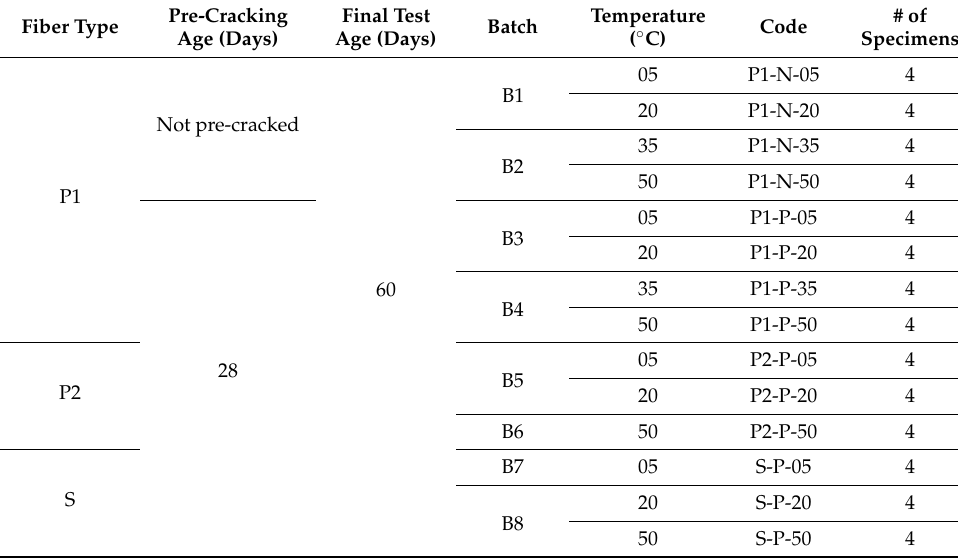
Table 4. Summary of the experimental program implemented.